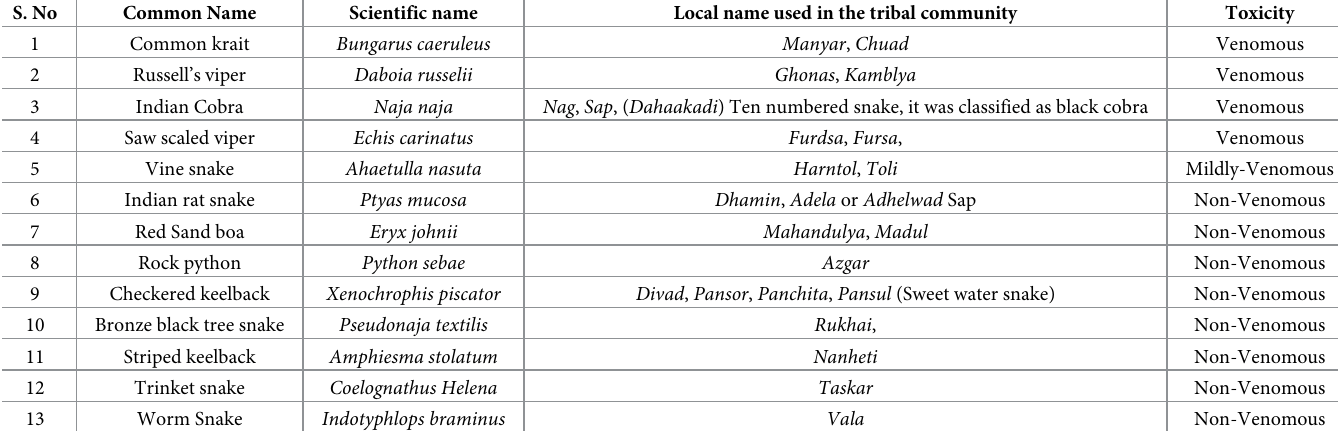
Table 1. The commonly found venomous and non-venomous snakes in the Dahanu block of Maharashtra, India.